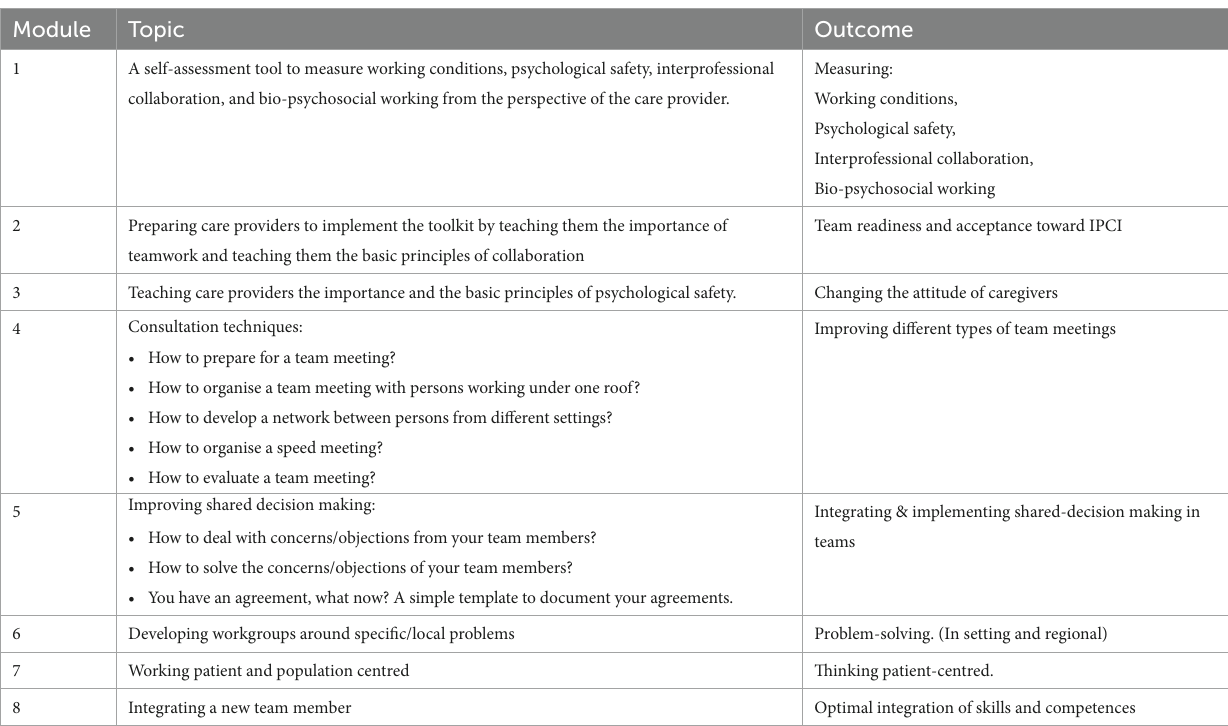
TABLE 8 “Building blocks” of the IPCI-toolkit.